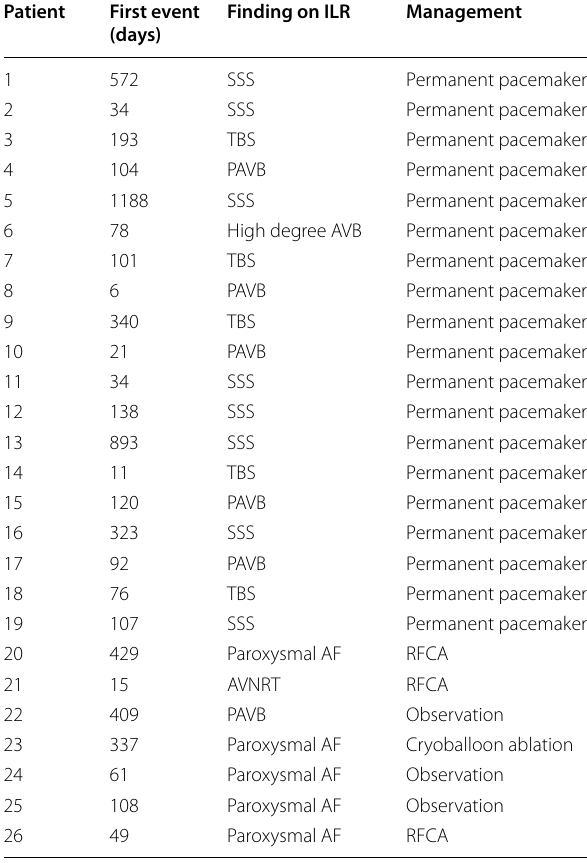
SSS, sick sinus syndrome; TBS, tachycardia-bradycardia syndrome; PAVB, paroxysmal atrioventricular block; AF, atrial fibrillation; RFCA, radiofrequency catheter ablation; ILR, implantable loop recorder; AVNRT, atrioventricular nodal reentry tachycardia